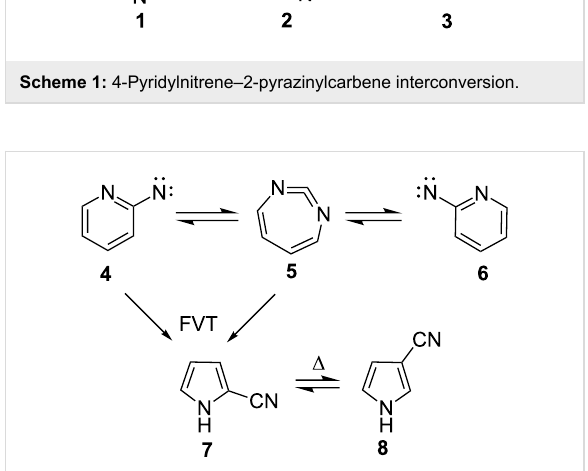
Scheme 2: Ring expansion and ring contraction in 2-pyridylnitrene ( 4 ).